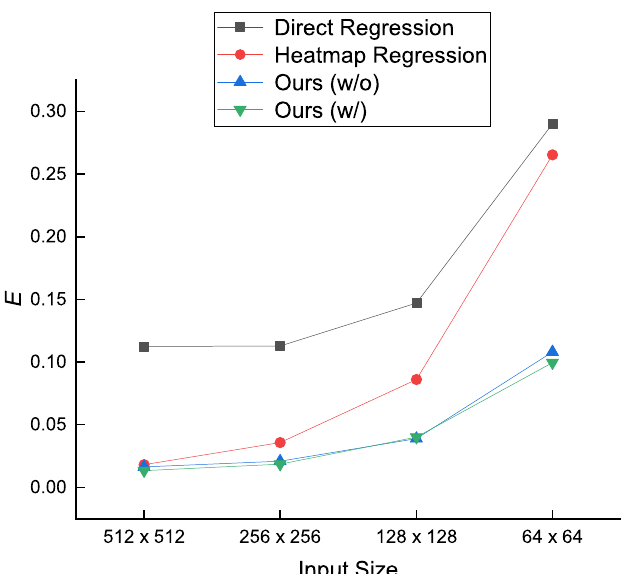
Figure 11. Comparison between our methods and the state-of-the-art methods in terms of the E metric at all input size